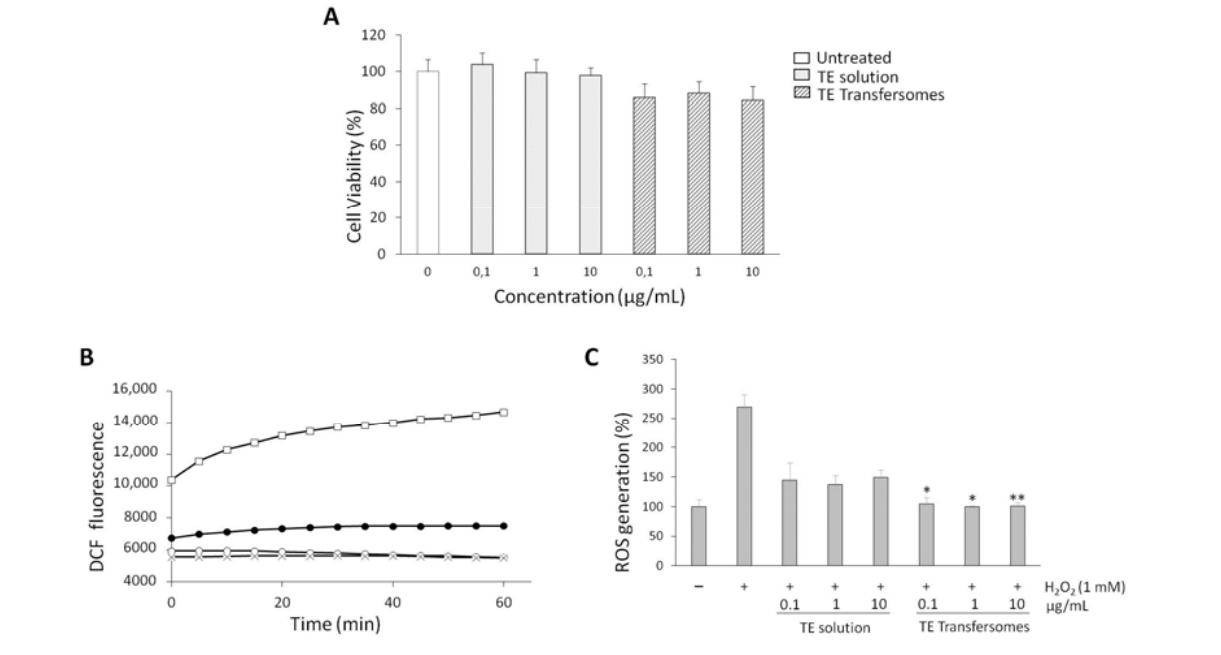
Figure 3. ( A ) Effects of Tempranillo extract (TE), in solution and in transfersomes, on HaCaT cell viability. ( B ) ROS levels (expressed as DCF fluorescence) in HaCaT cells pre-treated with Tempranillo extract (TE), in solution and in transfersomes (extract concentration: 1 µg/mL), and incubated with 1 mM of H 2 O 2 for 60 min. ( ○ ): Untreated cells; ( □ ): 1 mM H 2 O 2 ; ( ● ): TE + H 2 O 2 ; (x): TE transfersomes + H 2 O 2 . ( C ) Effects of Tempranillo extract (TE), in solution and in transfersomes, on ROS production in HaCaT cells after a 1 h treatment with 1 mM of H 2 O 2 . Means ± SDs of three independent experiments, each performed in triplicate, are shown. Asterisks (*) indicate statistical difference between TE transfersomes and TE solution at each concentration: * p < 0.05, ** p < 0.005.